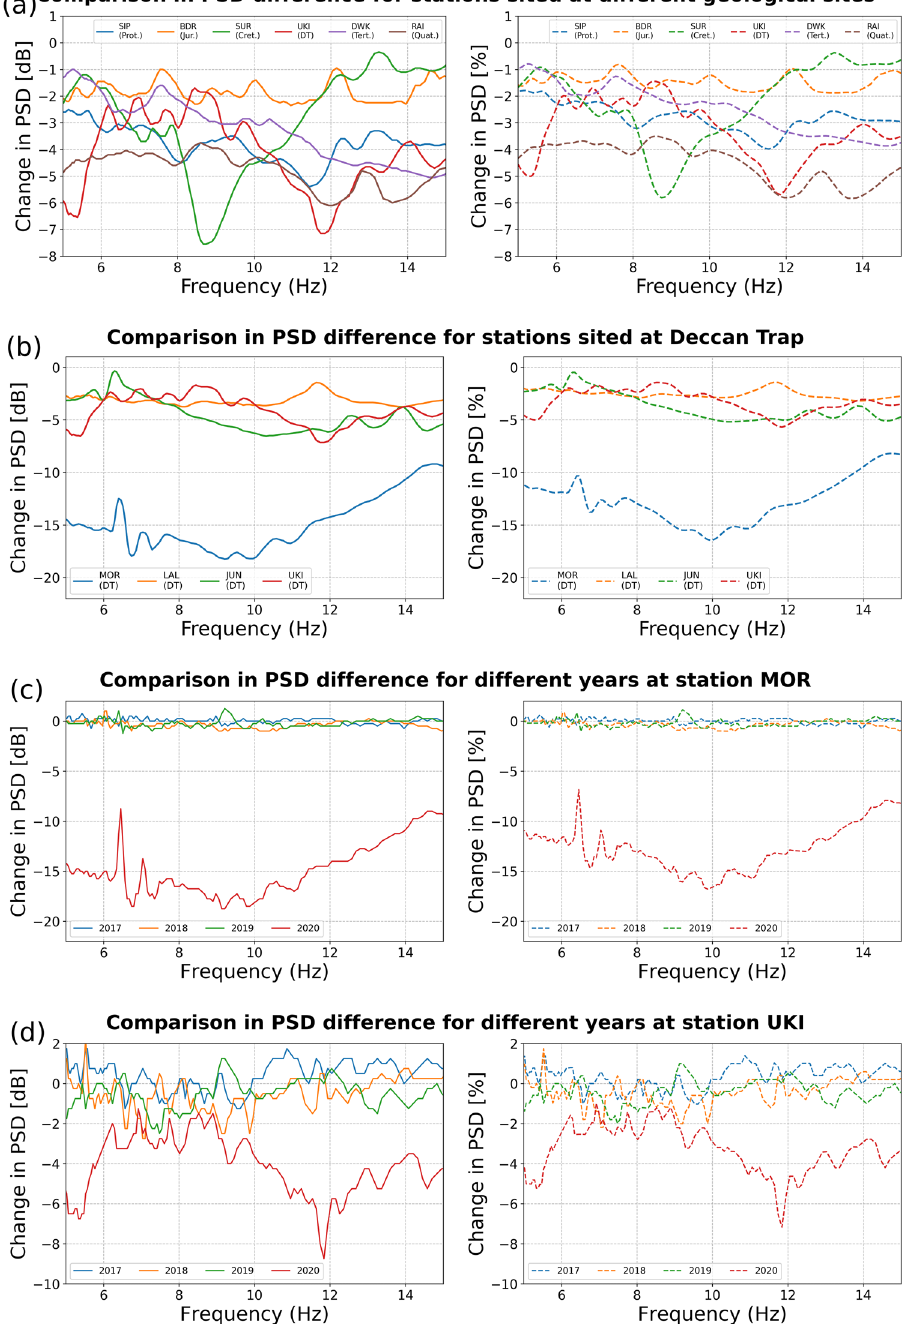
Figure 3. ( a , b ) The change in PSD values during co-lockdown period with respect to the pre- lockdown for different stations sited on varied and same geological formations. Here, change in PSD [dB] = median ( PSD ) co − lockdown − median ( PSD ) pre − lockdown , and change in PSD [%] = ( median ( PSD ) co − lockdown − median ( PSD ) pre − lockdown ) ∗ 100 / median ( PSD ) pre − lockdown . ( c , d ) The comparison in change in PSD values for different years for the same duration as in the pre- and co-lockdown periods are shown for stations MOR and UKI. The change in PSD values are represented in dB and percentage considering median values in the frequency range of 5–15 Hz, representative of anthropogenic noise sources. The subsurface geology and other local anthropogenic conditions are mentioned in Table